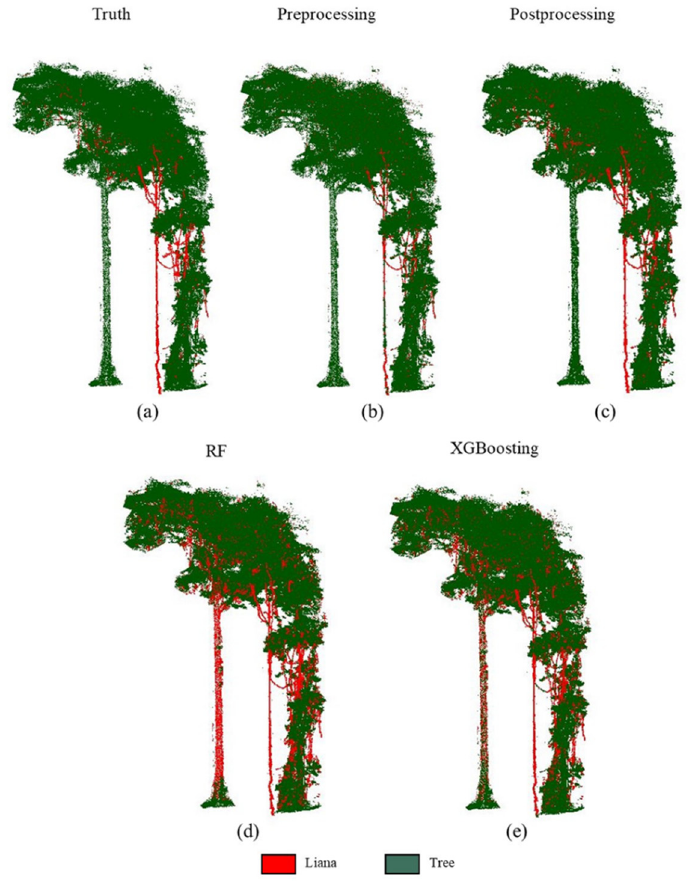
Figure 6. The predictions of different methods in Table 6, ( a ) Truth: manual labeled; ( b ) Preprocessing: Moorthy et al. [16] without manual intervention; ( c ) Postprocessing: Moorthy et al. [16] with manual intervention; ( d ) Proposed method based on RF algorithm; ( e ) Proposed method based on XGBoosting